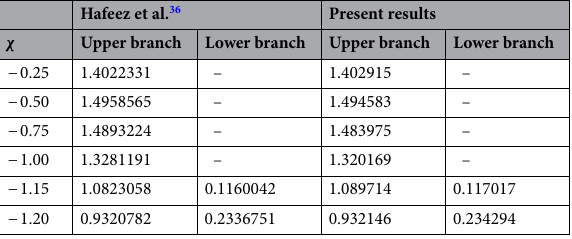
1 2 C f for regular fluid (φ 1 = φ 2 = 0 ) with shrinking parameter χ Table 2. The comparison of Re